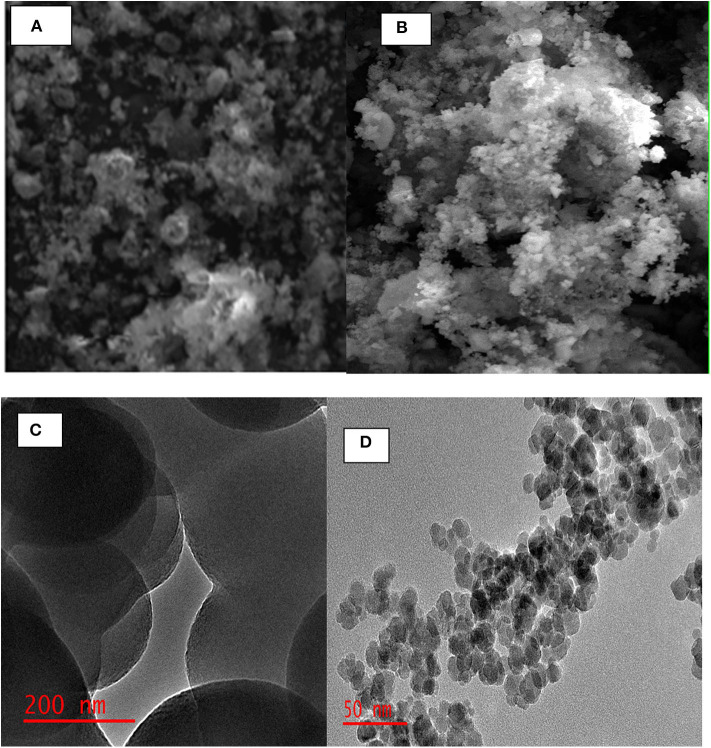
SEM images of (A) P-POP, (B) MP-POP and TEM images of (C) P-POP (D) of the M-PPOP.